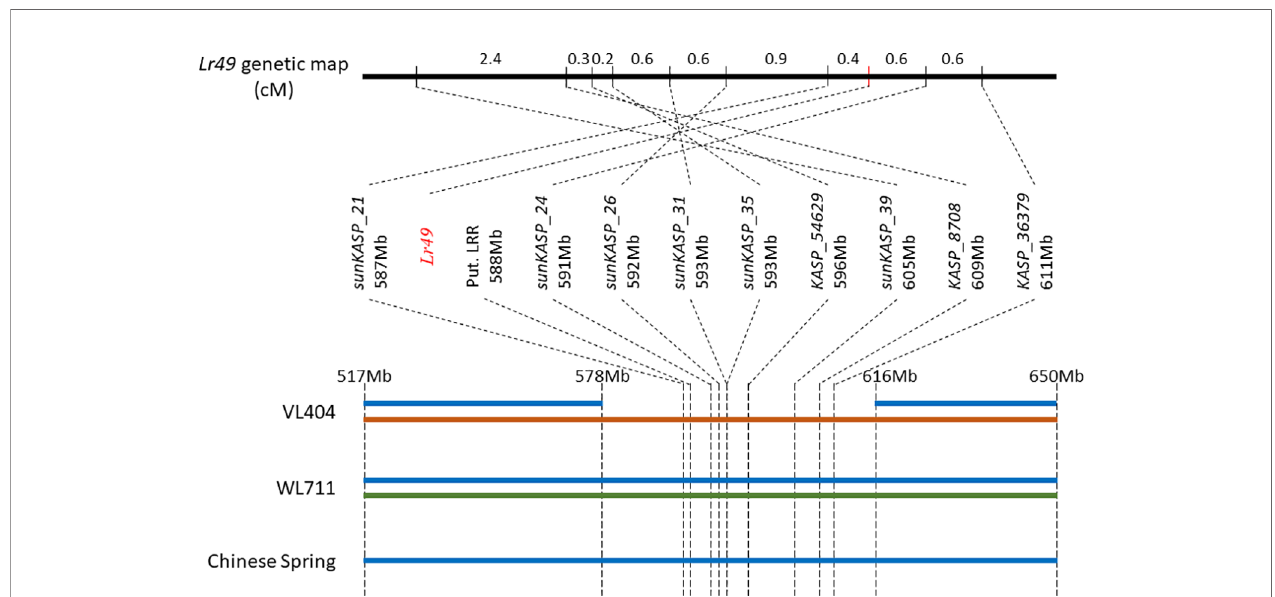
FIGURE 4 | Diagrammatic representation of the Lr49 interval and fl anking region on chromosome 4B. Both VL404 (resistant parent) and WL711 (susceptible parent) have two sequence haplotypes outside the Lr49 region, while VL404 has only one sequence haplotype within the Lr49 interval. Chinese Spring has only one sequence haplotype across entire region. Each unique sequence haplotype is represented by a different color. Markers mapping within the Lr49 interval are ordered based on their physical mapping location. The Lr49 genetic map does not re fl ect the physical mapping order as illustrated by comparison of genetic and physical map order across the Lr49 interval. Differences in sequence haplotype structure and physical-genetic map order in VL404 and WL711, relative to Chinese Spring, suggests structural rearrangement or copy number variation (CNV) relative to Chinese